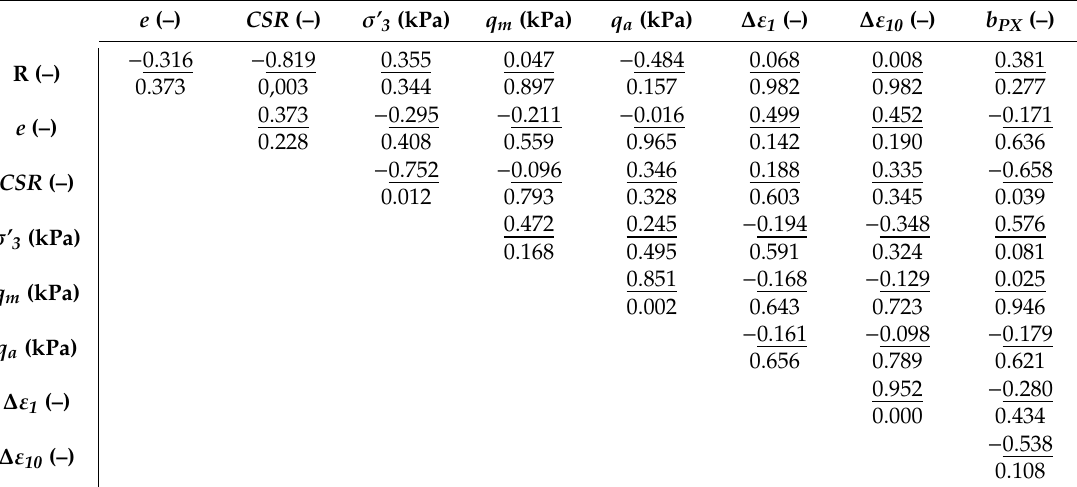
Table A2. Pearson correlation analysis result for b PX parameter.